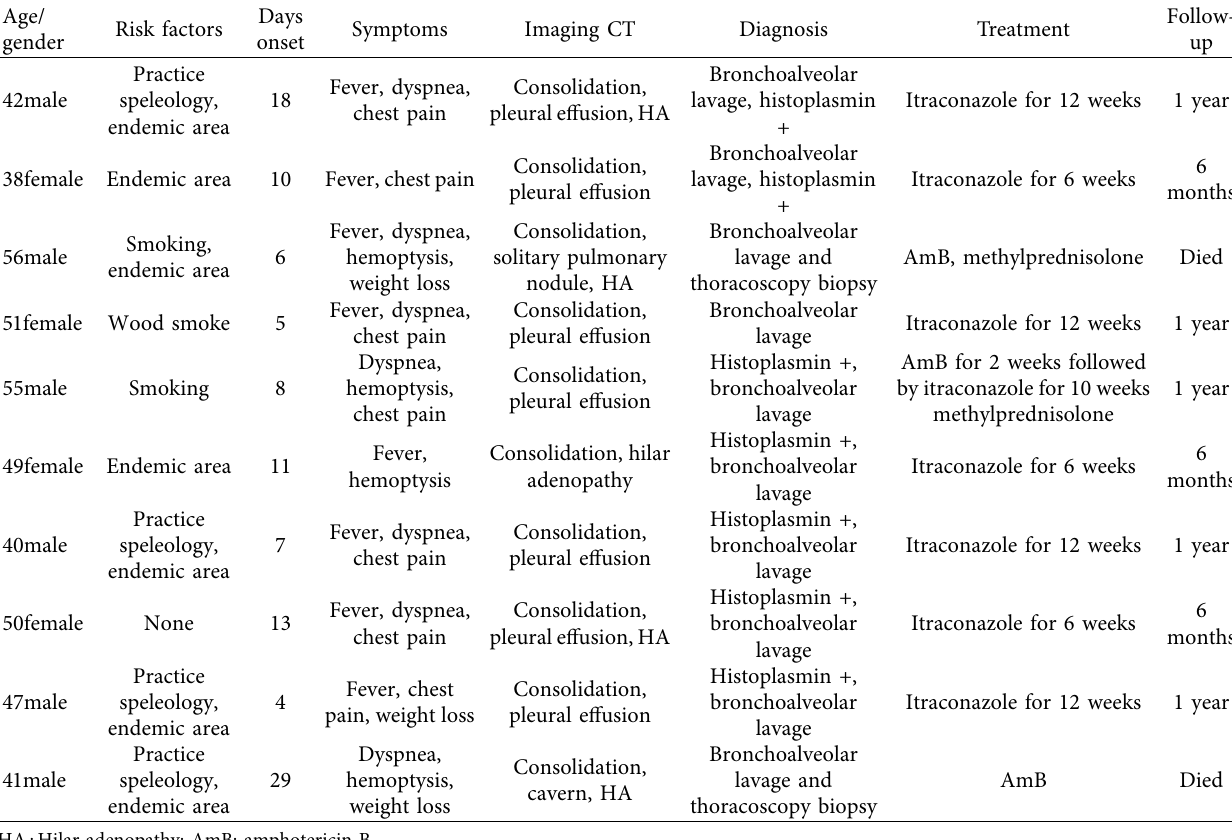
Table 1: Patients with acute histoplasmosis.